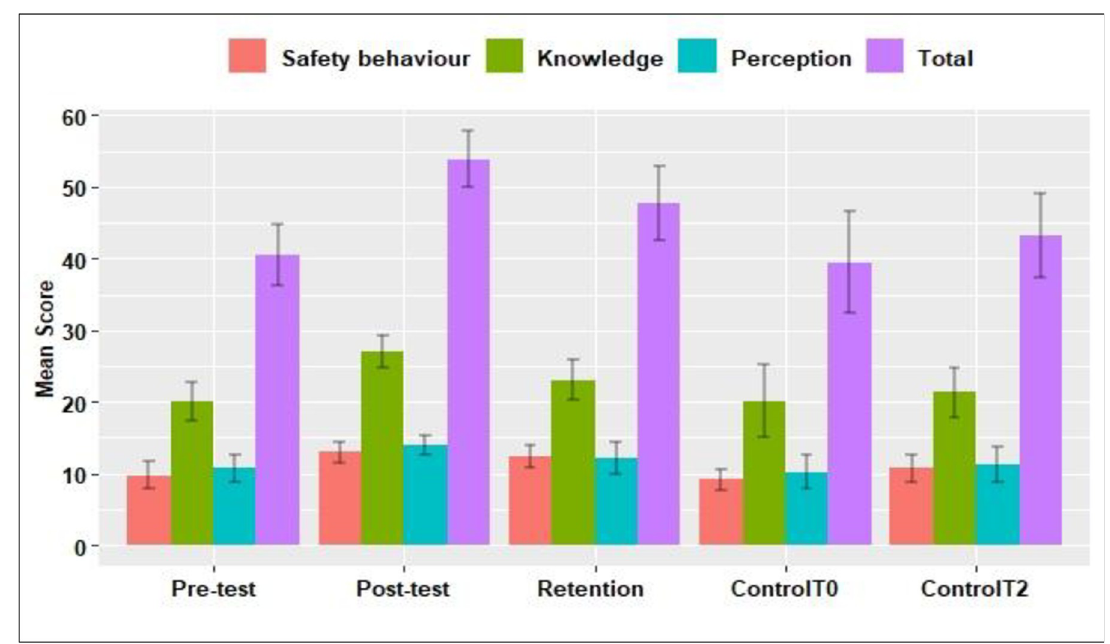
Fig 4. Bar graph showing the students mean scores (+/- Standard Errors) of knowledge, perception and safety behaviour around dogs at different time